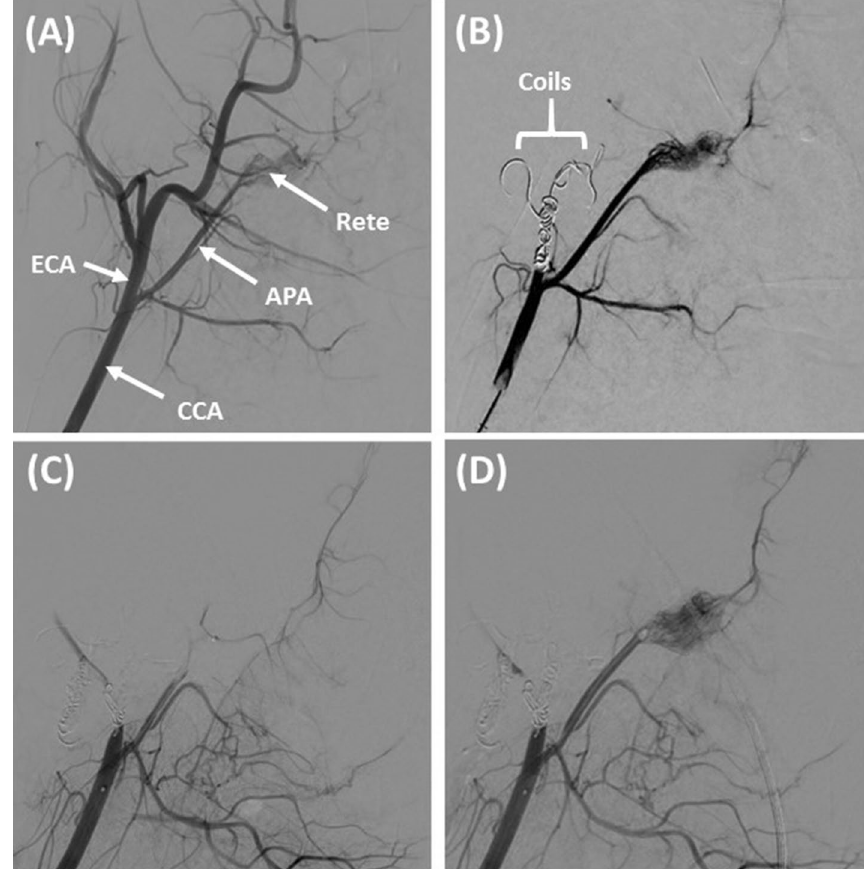
Figure 2. Representative digital subtraction angiographic images during in vivo procedure. Standard anatomy can be observed in ( A ). The common carotid artery (CCA) can be seen branching into the ascending pharyngeal artery (APA) and external carotid artery (ECA). The APA ends in the rete mirabile (Rete). The ECA is occluded using bare platinum and hydrogel coils ( B ), which diverts flow preferentially to the APA and reduces collateral circulation to the brain. The APA is successfully embolized with a human whole blood clot (mTICI < 2b) ( C ) and treated for 2 h with either sham, rt-PA only, or sonothrombolysis with Definity (2-h rt-PA only treatment arm shown with mTICI ≥ 2b)